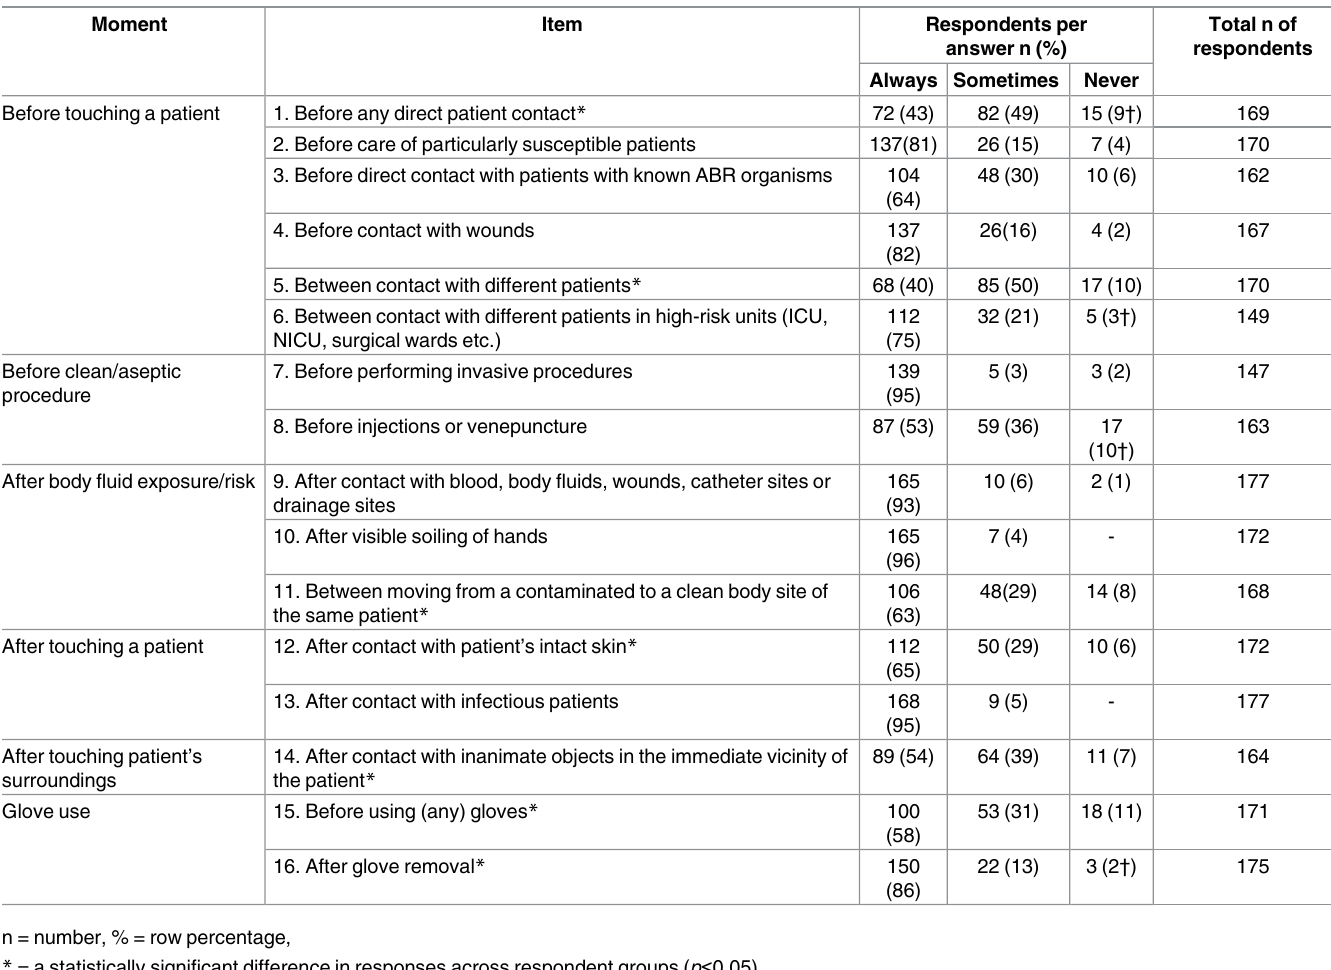
Table 2. Direct patient contact (DPC)respondents’ self-reported hand hygiene practices in study setting.